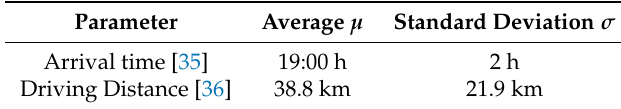
Table 2. Private vehicles mobility data of